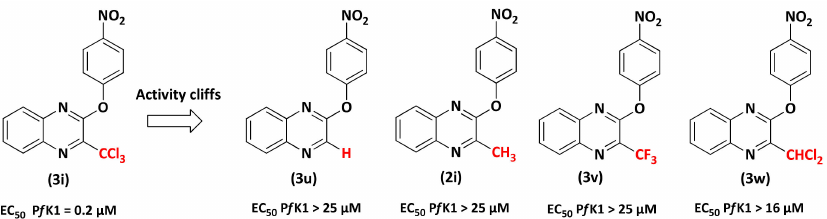
Figure 4. Comparison of the in vitro antiplasmodial activities of hit molecule 3i with analogs 3u , 3v , 3w , 3x